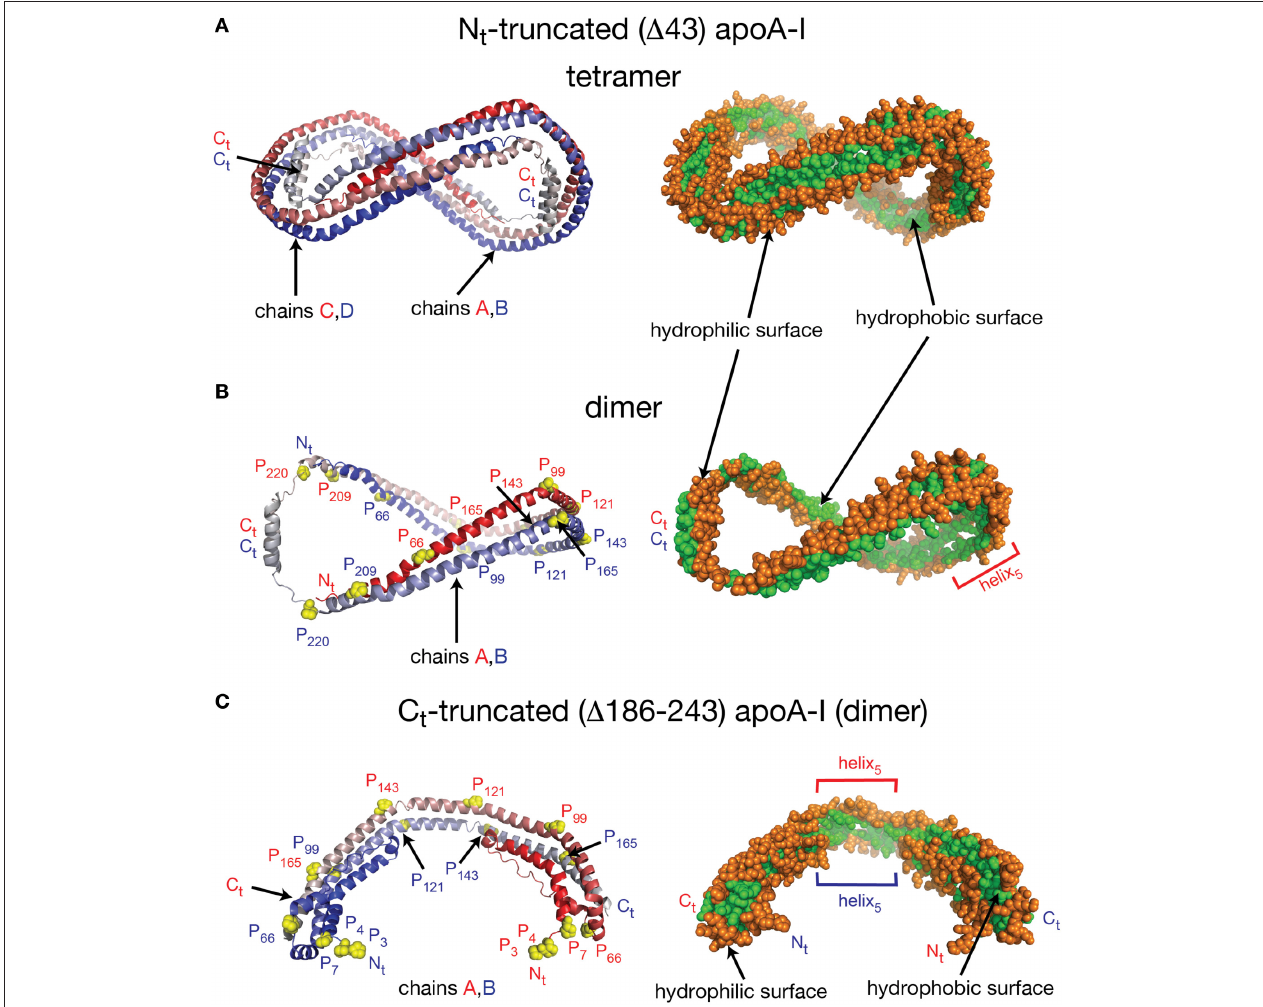
FIGURE 1 | Crystal structures of truncated lipid free apoA-I. Both crystal structures have the apoA-I chains orientated antiparallel in helix 5 registry, i.e., the helix 5 domains (P 121 –S 142 ) from both chains are on top of each other. (A) Left: Cartoon representation of the crystal structure of the 1 43–apoA-I (N t truncated apoA-I) tetramer (PDB id: 1AV1). The structure shows two twisted apoA-I dimers (A,B and C,D) mutually interacting through their hydrophobic surfaces created by the protein chains when in α -helix conformation. The chains in each dimer are colored with gradient red/blue (N t solid color and C t faded color). Right: sphere representation = = of the hydrophobic (green) and hydrophilic (orange) surfaces of the apoA-I tetramer. (B) The crystal structure of the 1 43–apoA-I (N t truncated) dimer (PDB id: 1AV1). Left: Proline residues that initiate 11 and 22 residue repeats are shown as yellow spheres. Right: the hydrophilic/hydrophobic surface of the dimer in sphere representation. The C t domains of apoA-I chains have their hydrophobic surface facing outside the closed-loop dimer, while the helix-5 domains have their hydrophobic surface facing inside the dimer. (C) Left: Cartoon representation of the crystal structure of the C t truncated form of lipid free apoA-I (1–185; PDB id: 3R2P). The N t is shown to fold back and interact with the rest of the chain. Right: the hydrophilic/hydrophobic surface of the dimer is color coded with green/orange, respectively. The N t domains of apoA-I chains have their hydrophobic surface facing toward the central region of the dimer, while the helix-5 domains have their hydrophobic surfaces facing each other.